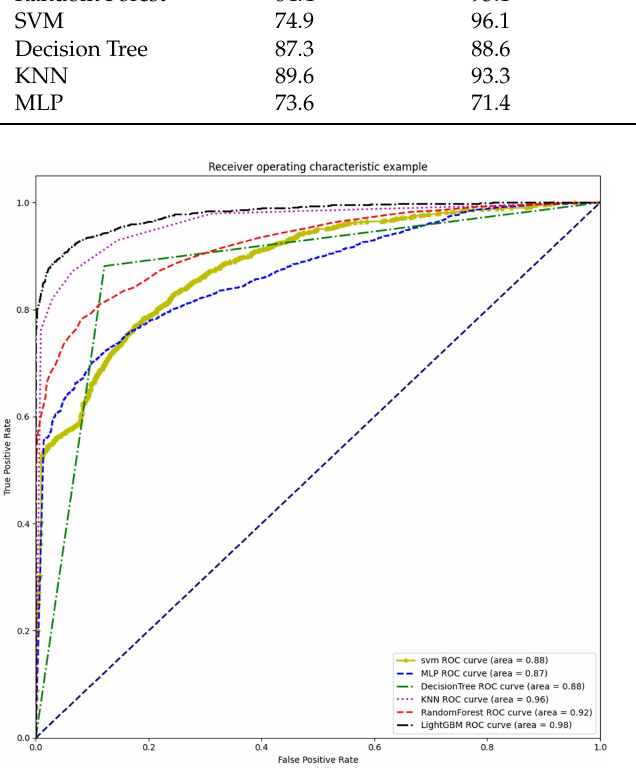
Figure 8. ROC curves of different